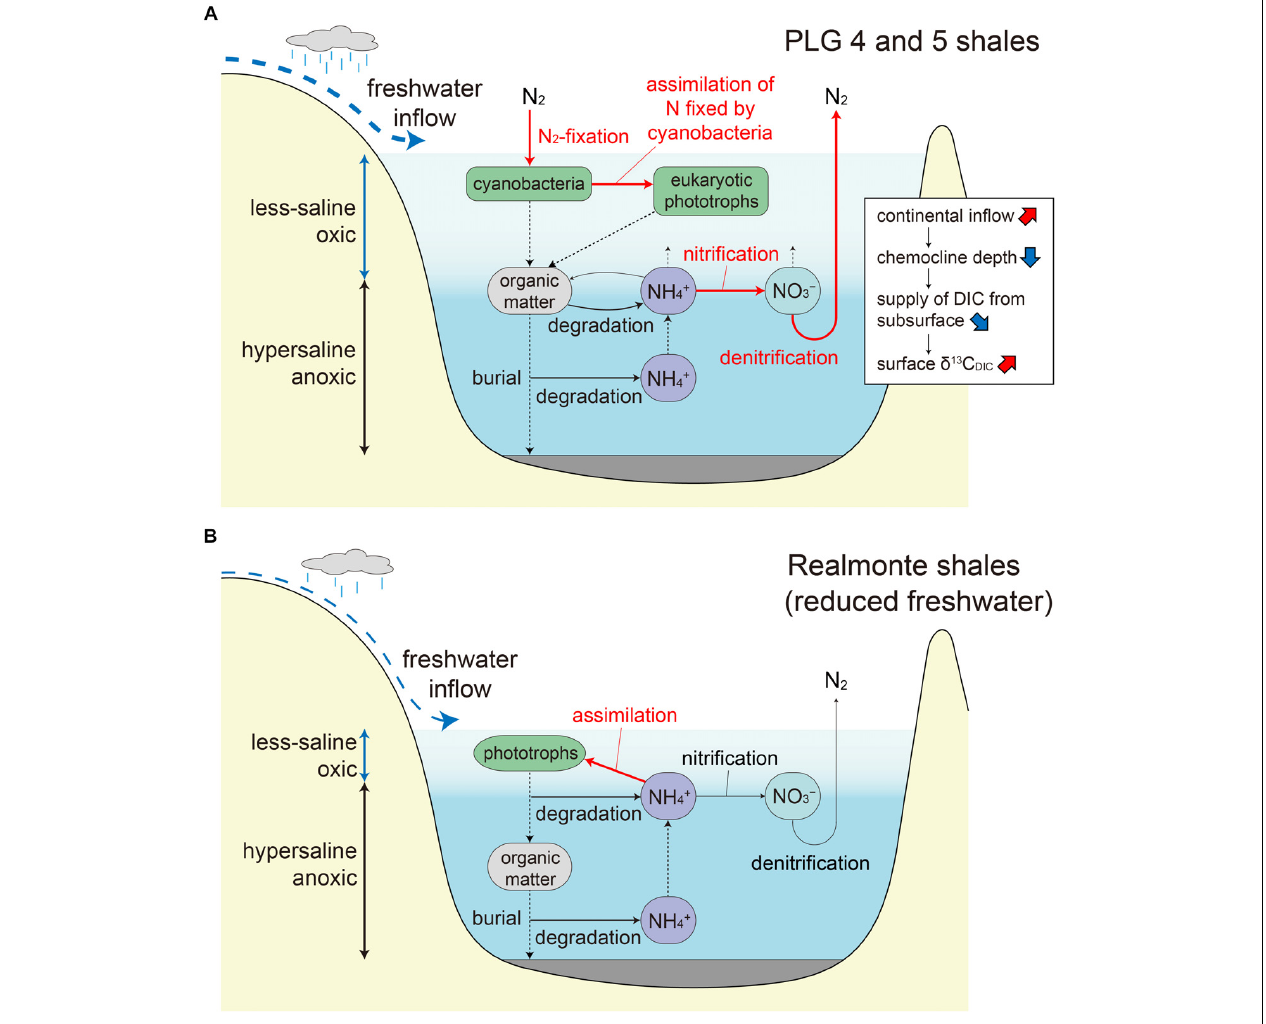
FIGURE 5 | (A) Proposed nitrogen cycle during the deposition of the PLG 4 and 5 shales. Water column stratification resulted in active denitrification (and/or anammox) and limited nitrogen supply to the surface photic zone, resulting in surface water oligotrophy favorable for diazotrophic cyanobacteria. The surface freshwater layer is thicker and the chemocline is deeper during the deposition of the PLG 5 shale due to an increase in regional precipitation, which resulted in a reduced supply of 13 C-depleted dissolved inorganic carbon from the bottom hypersaline layer. Important processes are indicated by red arrows. (B) Proposed nitrogen cycle under reduced freshwater input during the MSC peak (Isaji et al., 2019). The shallow chemocline results in phototrophic assimilation of the subsurface ammonium rather than nitrification followed by denitrification (and/or anammox).